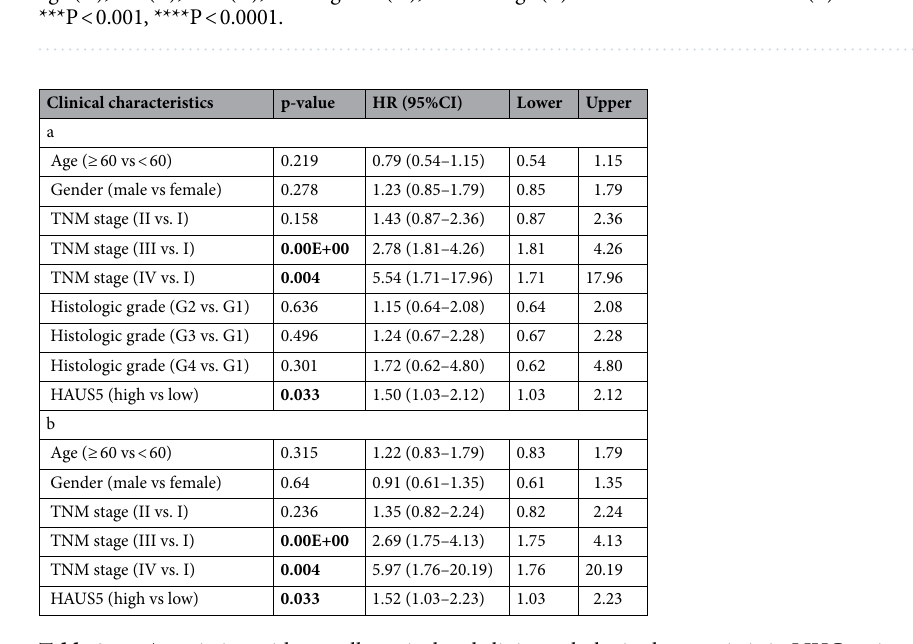
Table 2. a. Association with overall survival and clinicopathologic characteristic in LIHC patients using univariate cox regression. b. Multivariate survival analysis using cox regression. Bold values indicate p < 0.05.